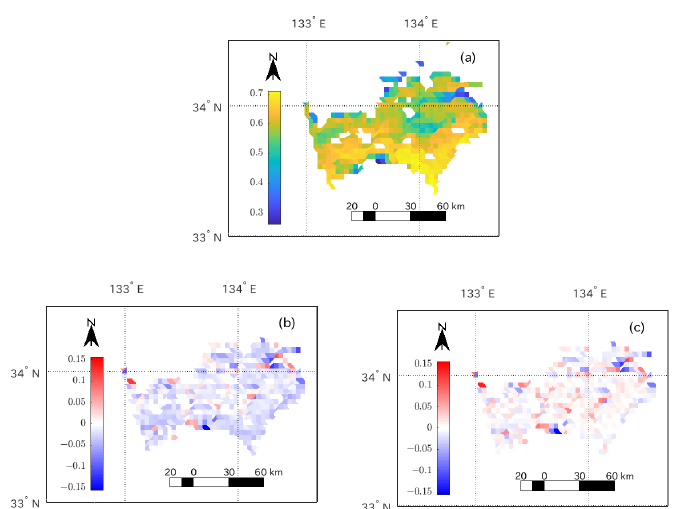
Figure 8. Maps of aggregated NDVI and their differences between AHI and MODIS for the data corresponding to Shikoku region on 13 April 2018: ( a ) MODIS NDVI, ( b ) AHI NDVI minus MODIS NDVI, and ( c ) transformed AHI NDVI minus MODIS